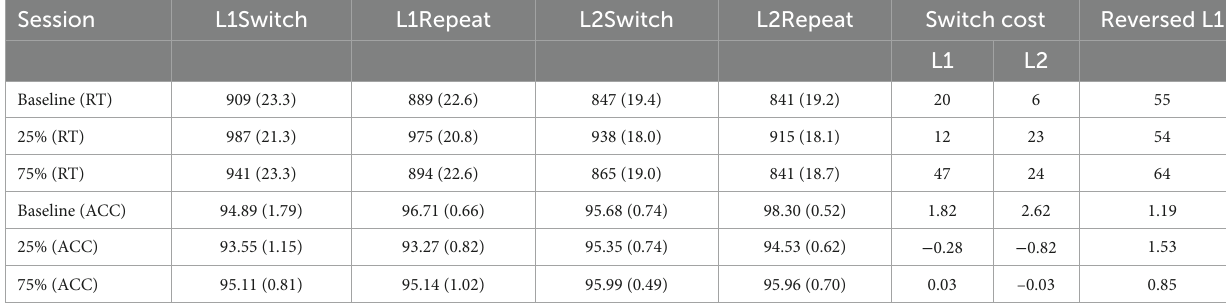
TABLE 1 Averaged response time (ms) and accuracy rates (%; standard errors in parentheses) in three